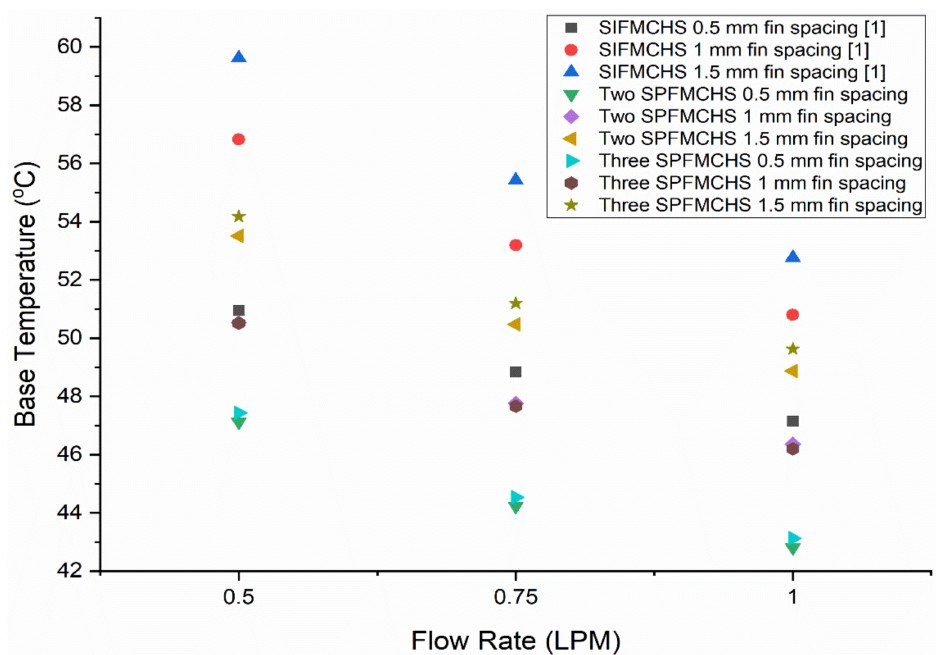
Figure 13. Base temperature with volumetric flow